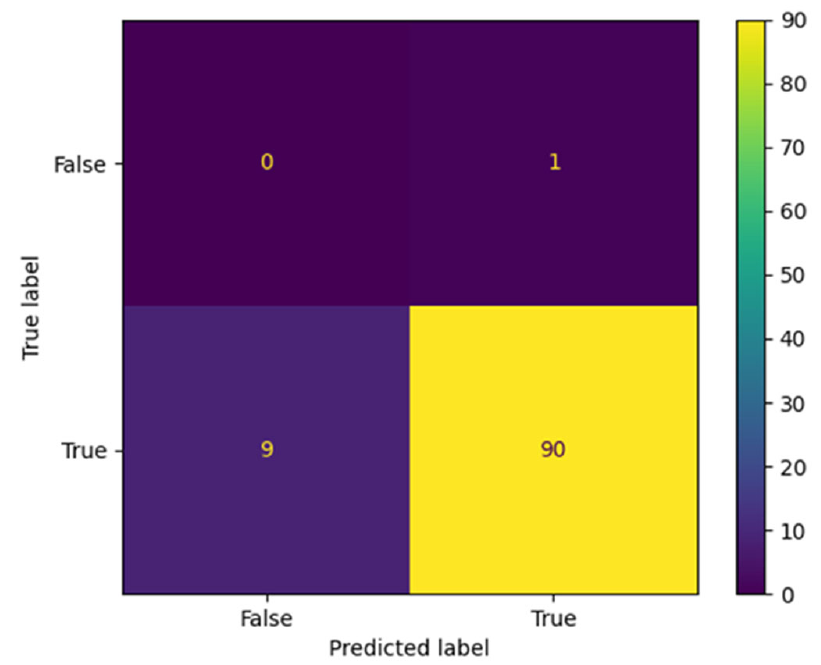
Figure 9. Confusion matrix obtained by AraBERT on the STC dataset.